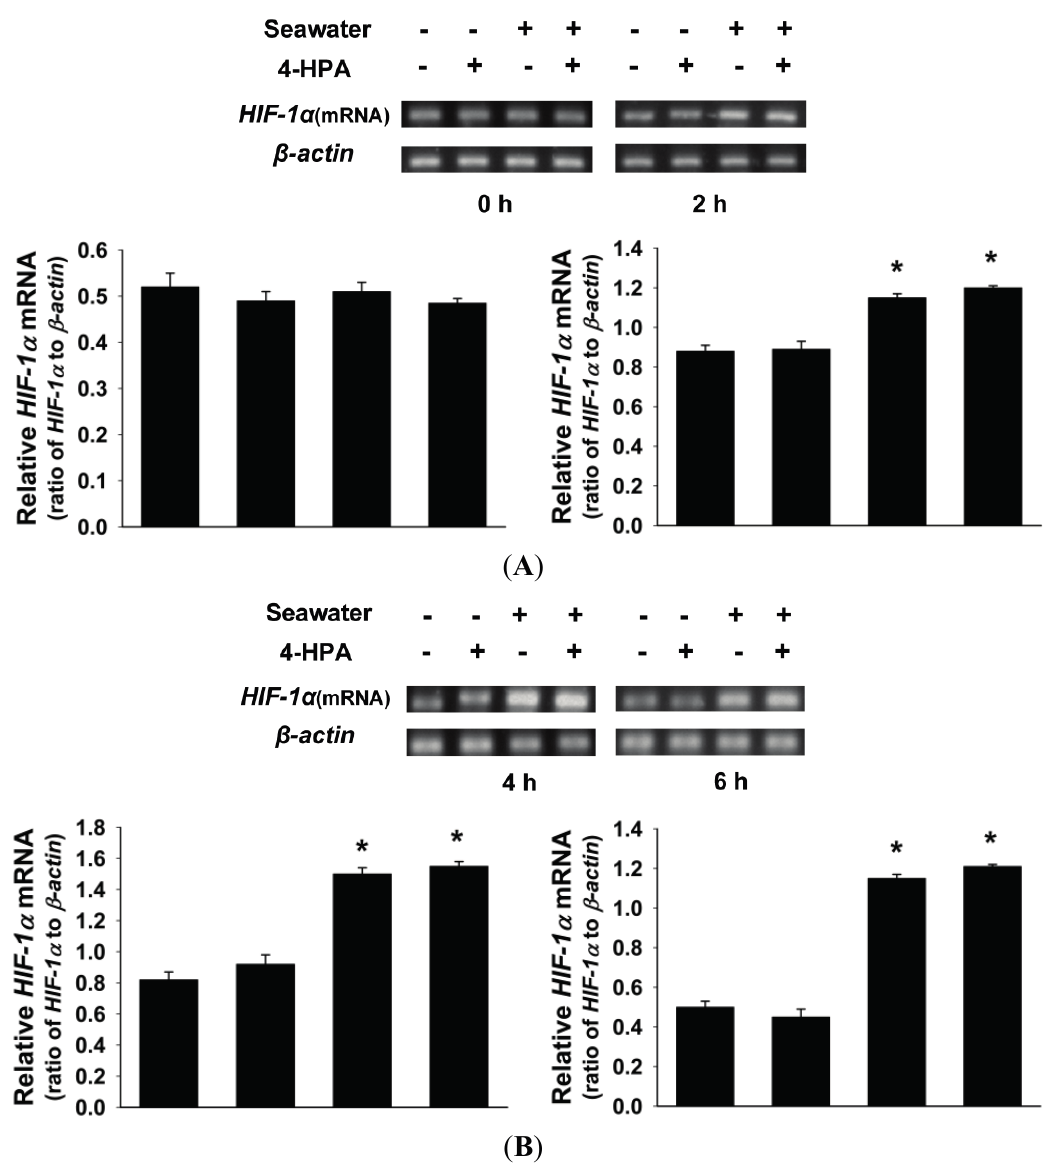
Figure 4. Effects of 4-HPA on seawater instillation-induced HIF-1 α protein and mRNA levels in lungs. After instillation of seawater for 0, 2, 4, and 6 h in the absence or presence of 4-HPA, HIF-1 α protein ( C , D ) and HIF-1 α mRNA ( A , B ) levels of lung tissue were detected by Western blotting and RT-PCR. The ratios of HIF-1 α to β -actin in protein and mRNA levels from three independent experiments were obtained by density scanning of the Western blotting and PCR band using an image analysis system. Data are means ± SD, * p < 0.05 vs. control group, # p < 0.05 vs. seawater